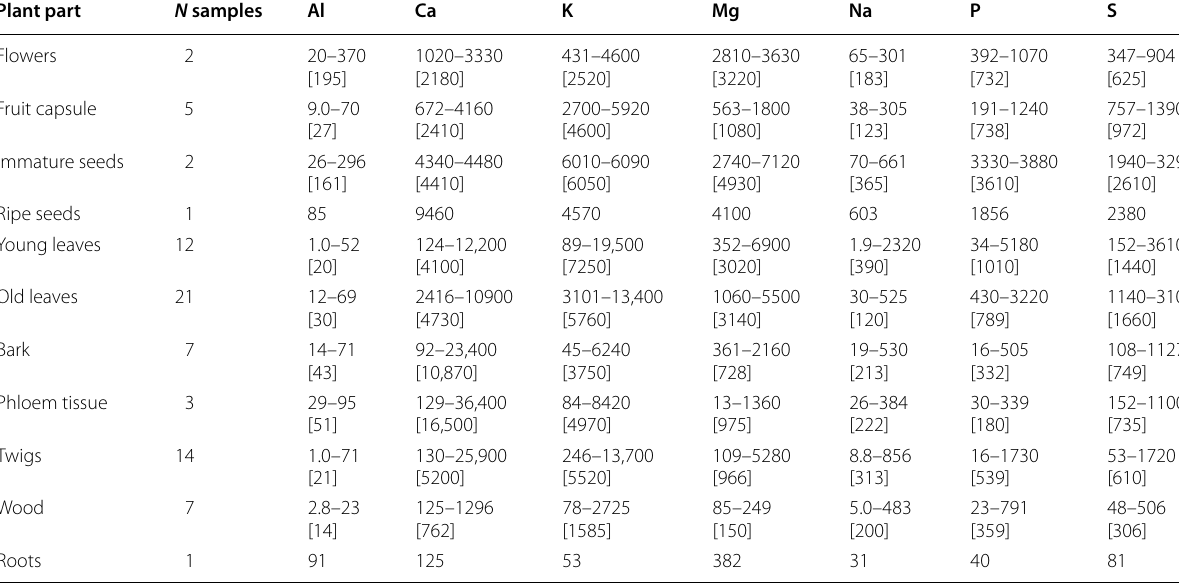
All values provided in μg g − 1